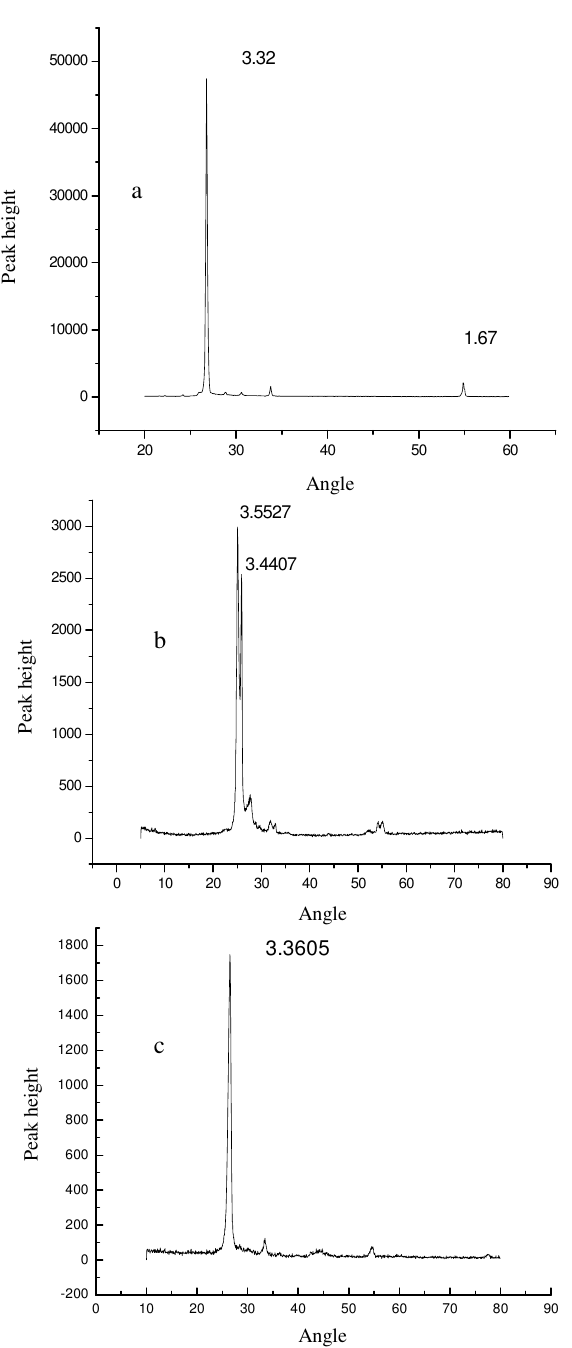
Figure 1. XRD of graphite expandable graphite and EG (a) graphite; (b) expandable graphite; (c) EG loaded with